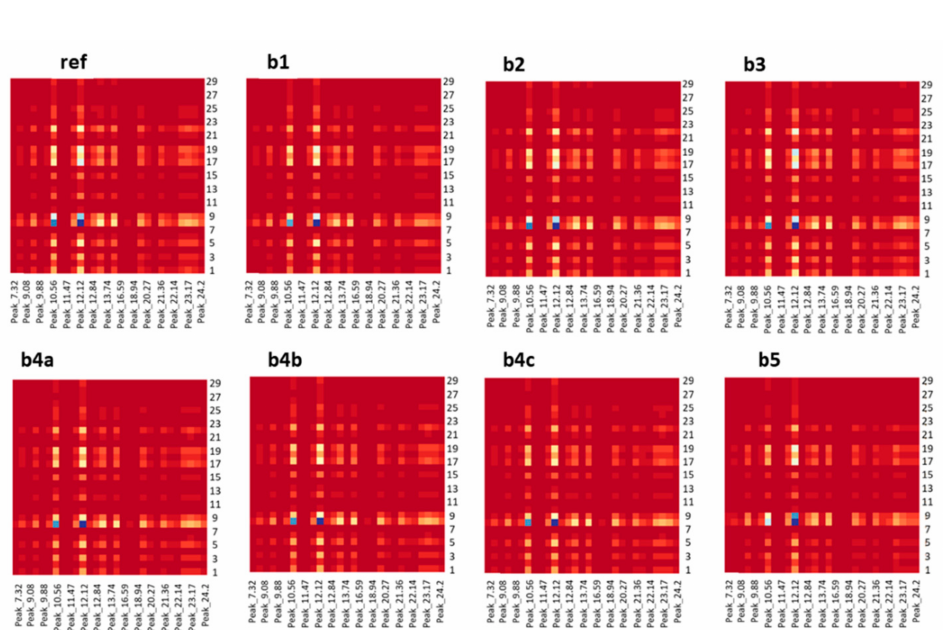
Figure 4. Heatmaps for the peak ratios in the reference batch and the batches b1, b2, b3, b4 (a, b, c) and b5 that were produced using the “stats” package in RStudio. Low and high extreme values are emphasized with dark colors, while light colors represent middle